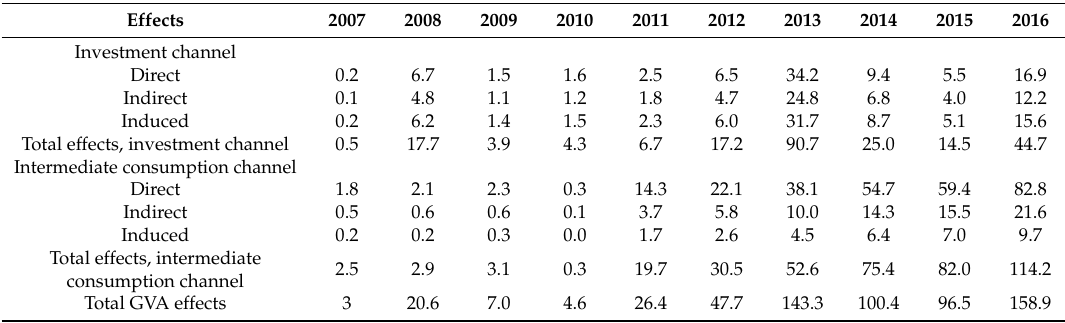
Table 4. Total GVA induced by wind power plants deployment and operation in Croatia, in millions of euros.